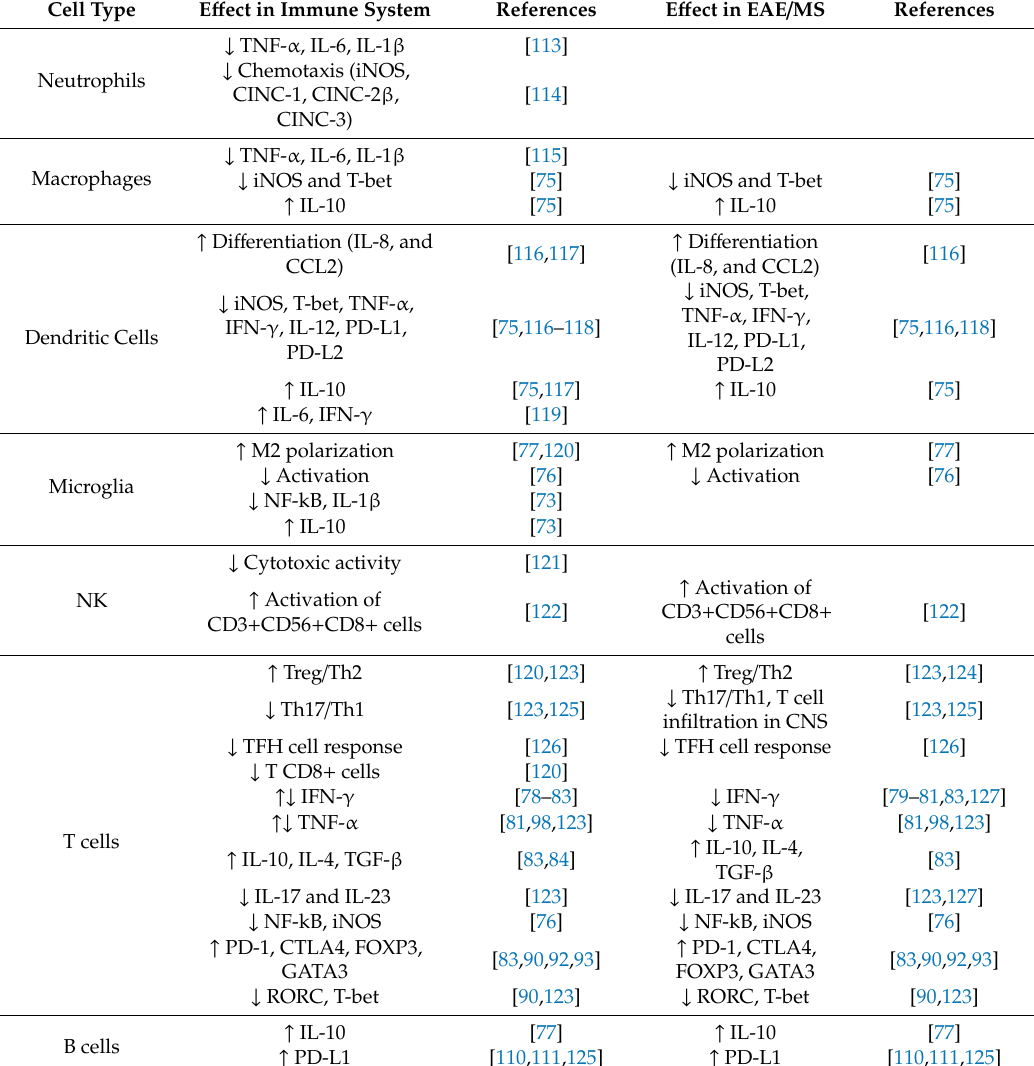
Table 1. E ff ect of estrogens on di ff erent immune cell